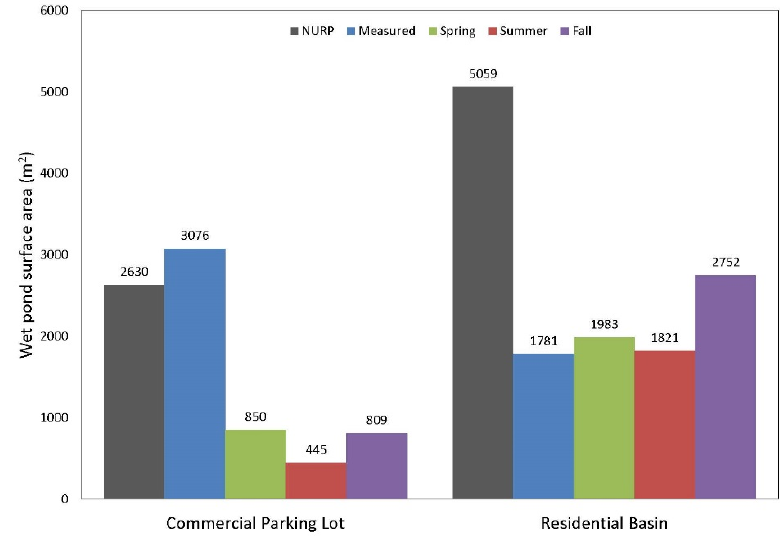
Figure 5. Surface area of a wet pond design required removing 80 percent of the total suspended solids load using NURP, the median of the measured and seasonal PSDs in the commercial parking lot and residential basin study areas.